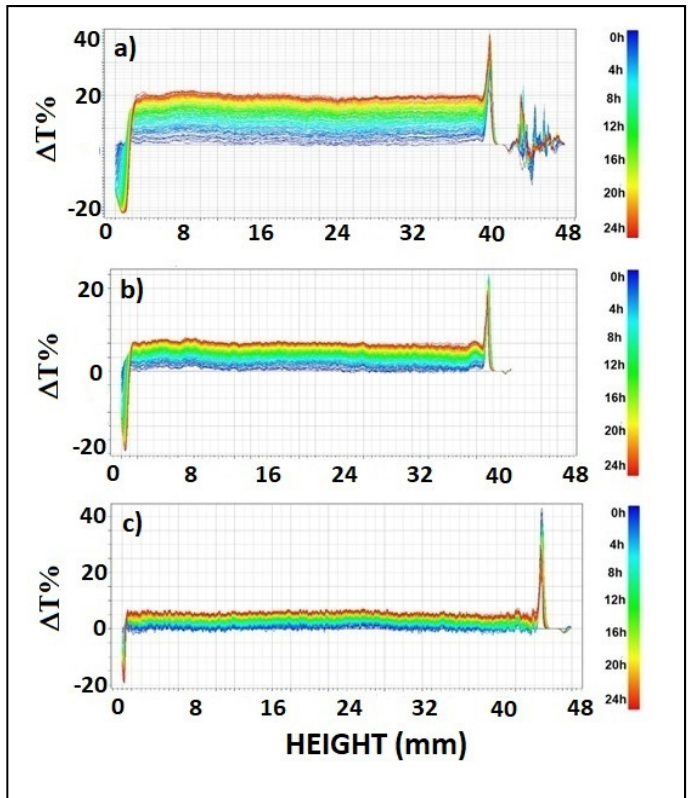
Figure 2. Profiles of Delta transmittance, Δ T(%), in each dispersion sample (analysis time: 24 h) ( a ) S-CMC 1 , ( b ) S-CMC 2 , and ( c ) S-CMC 3 .